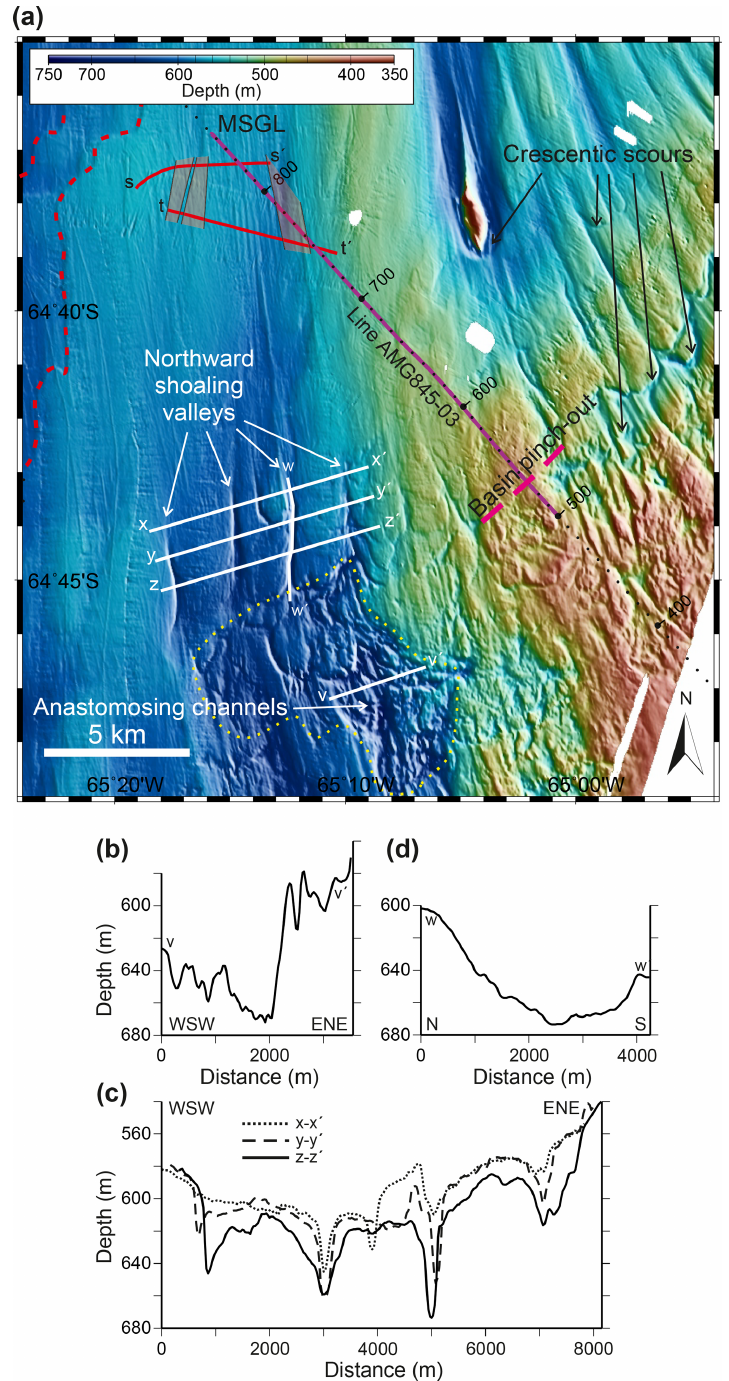
Figure 2. (a) Details of multibeam bathymetry over the boundary of the mid-shelf basin in the southern part of Anvers-Hugo Trough. Grid- cell size 30m, displayed with shaded relief illumination from 075 ◦ . Dashed red lines mark interpreted former grounding zone positions. The purple line marks the location of the MCS profile in Fig. 3, with small dots at intervals of 10 shots and larger dots and annotations at 100-shot intervals. White lines mark locations of topographic profiles in (b) – (d) and solid red lines mark locations of acoustic sub-bottom profiles in Fig. 4. Semi-transparent pink-filled areas crossing the sub-bottom profiles mark the positions of the buried channels observed in the profiles and interpolated between them. The yellow dotted line outlines the approximate extent of the area of anastomosing channels. MSGL, mega-scale glacial lineations. (b) Profile across anastomosing channels. (c) Cross sections of northward-shoaling valleys. (d) Profile along the axis of one northward-shoaling valley. Locations of profiles shown in (a)